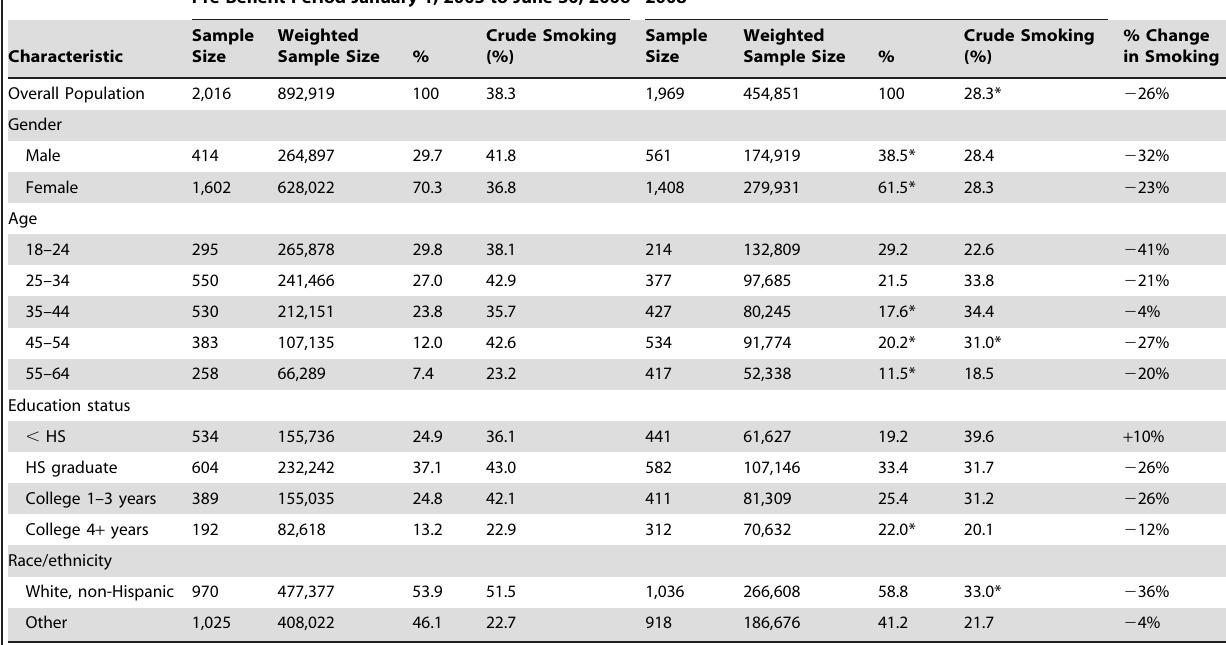
Table 2. Demographics for the MassHealth Population, Age 18–64 for the Pre- and Post- Benefit Periods with Crude Smoking